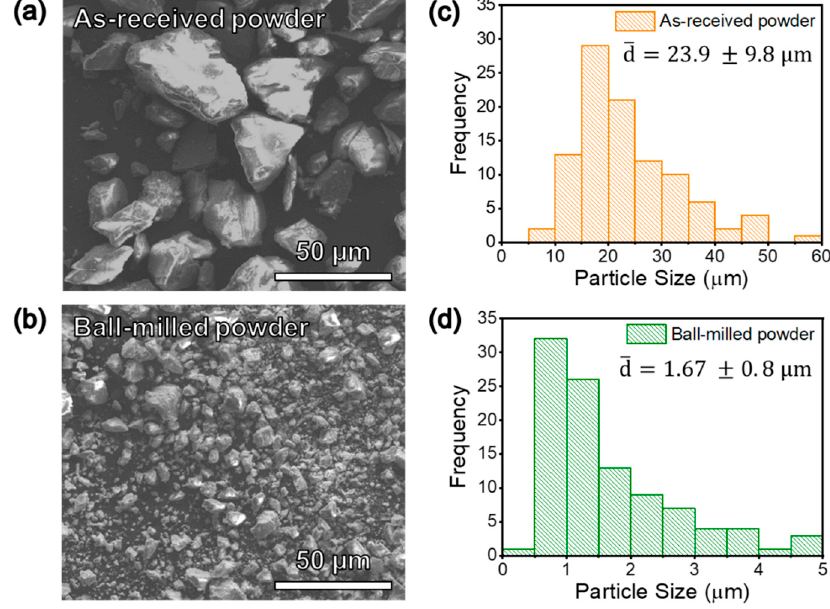
Figure 1. SEM images of the ( a ) as-received and ( b ) ball-milled JSC-1A powder. The corresponding particle size distributions are shown in ( c , d ).